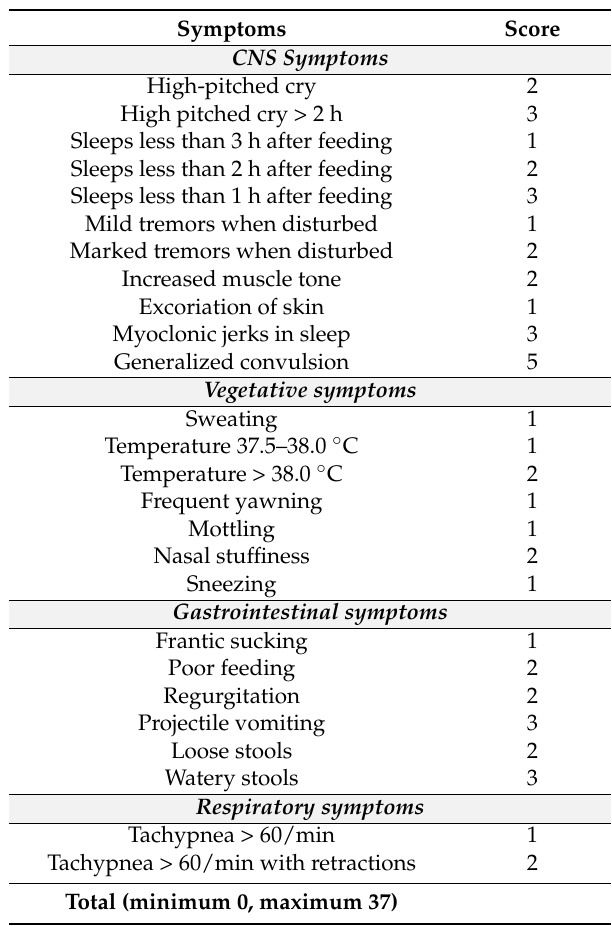
Table 2. Finnegan score system modified by Zimmermann-Baer et